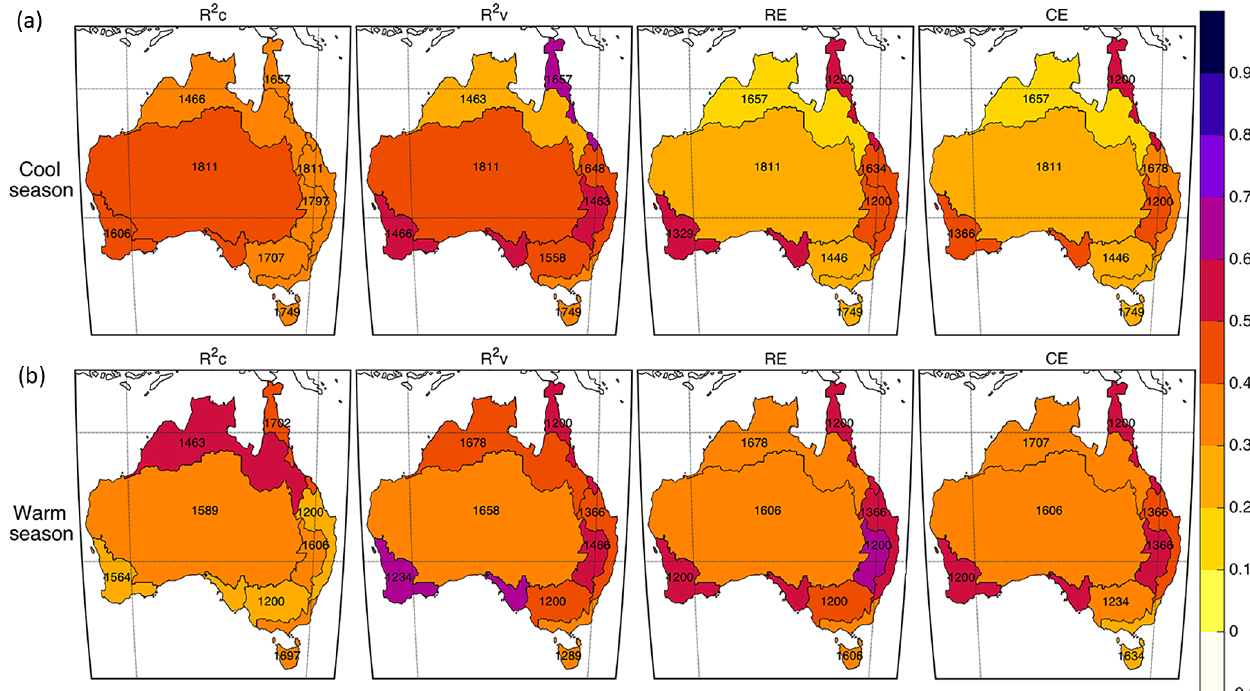
Figure 3. Maps of calibration and verification statistics for the NRM regions. Columns from left to right are variance explained in the calibration period ( R 2 c ), variance explained in the verification period ( R 2 v ), reduction of error (RE) and coefficient of efficiency (CE) statistics for both the cool season (a) and the warm season (b) . Statistics shown apply to the most replicated nest of the reconstruction. Numbers shown in each region indicate, for explained variance, the year in which R 2 c and R 2 v reduce to half of their maximum value, respectively; those for RE and CE indicate the year in which RE and CE remain positive, allowing for brief periods of negative skill of duration less than 5